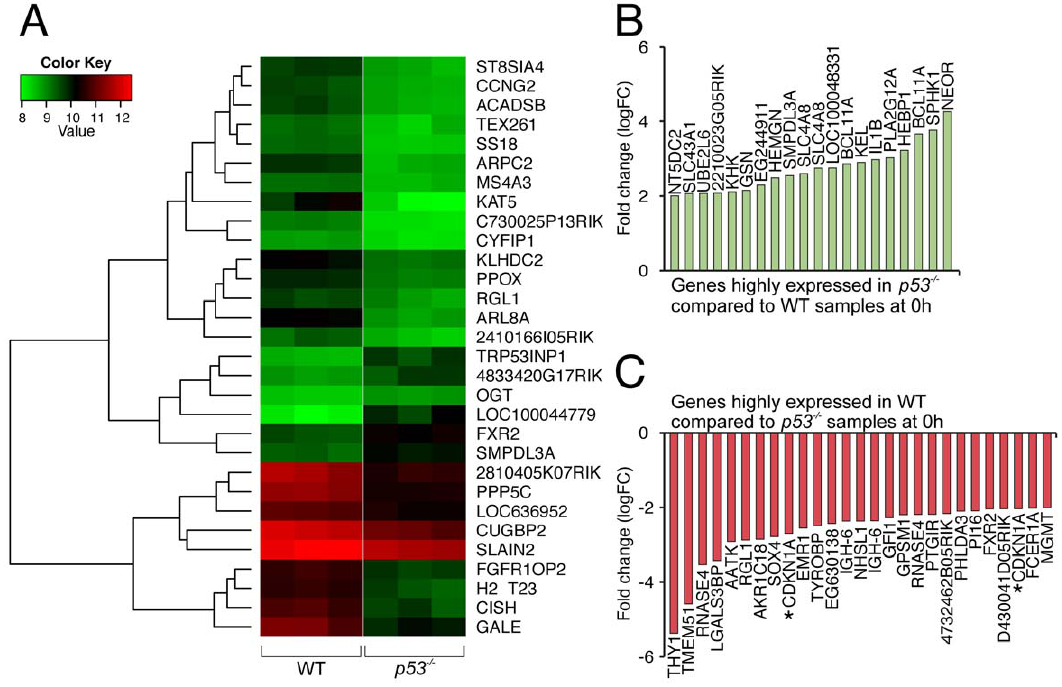
Figure 1. Differential gene expression in WT and p53 2 / 2 FDM samples. (A) RNA from three independent WT and p53 2 / 2 FDM cell lines were analyzed with the use of the 6-chip Illumina expression array. The heatmap depicts the expression of the top 30 differentially expressed genes according to the adjusted P value in WT and p53 2 / 2 samples. (B) Differentially expressed genes highly expressed in p53 2 / 2 compared to WT samples with a logFC change of greater than 2 are shown. (C) Differentially expressed genes highly expressed in WT compared to p53 2 / 2 samples with a logFC change of greater than 2 are shown. Asterisks show the p53-dependent gene CDKN1A (p21).